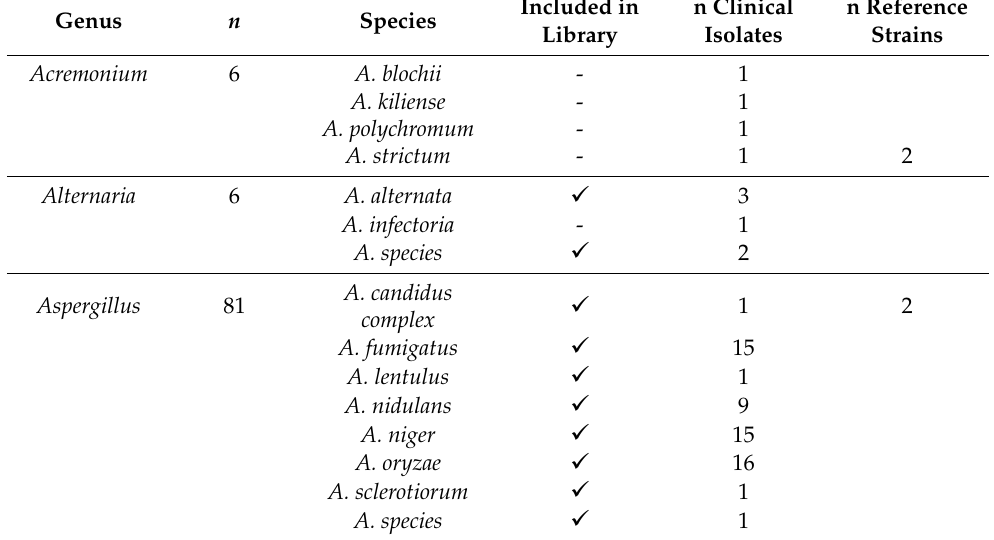
Table 1. Isolates included in the study ( n = 230). Clinical isolates ( n = 185) identified with high confidence (at species level) ( n = 161) and only identified with low confidence (at genus level) ( n = 24), respectively. Reference strains ( n = 45). Abbreviations: n: number; library: Bruker Filamentous Fungi Library